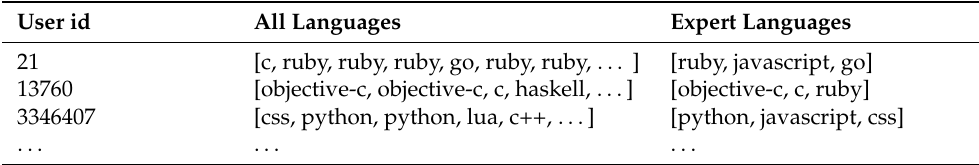
Table 7. The coding languages that experienced in past for each